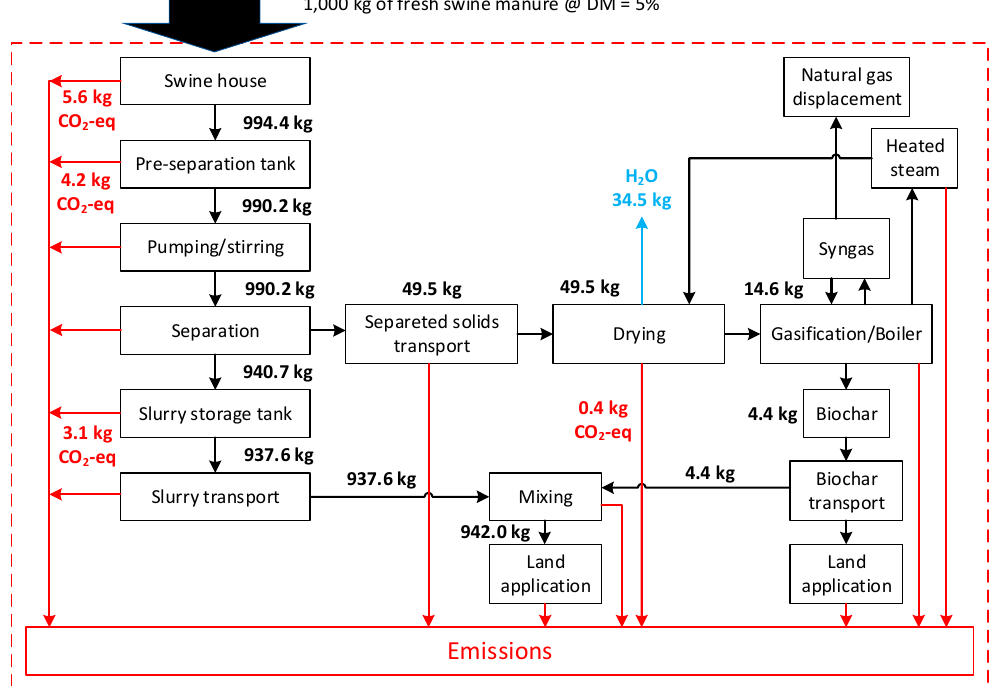
Figure 1. The scope of proposed swine manure management scenario illustrating mass balances and emissions flows (Note: black arrows represent main product flow; red arrows represent direct and indirect greenhouse gas (GHG) emissions. Blue arrow represents water evaporation. Numbers in red are direct emissions of GHG in kg CO 2 -eq).